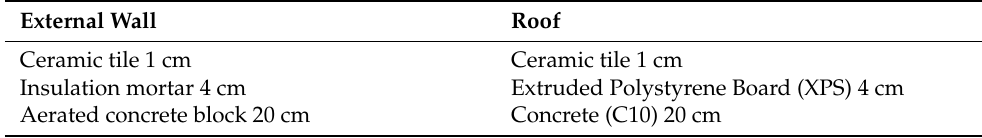
Table 4. Wall configuration of the buildings in